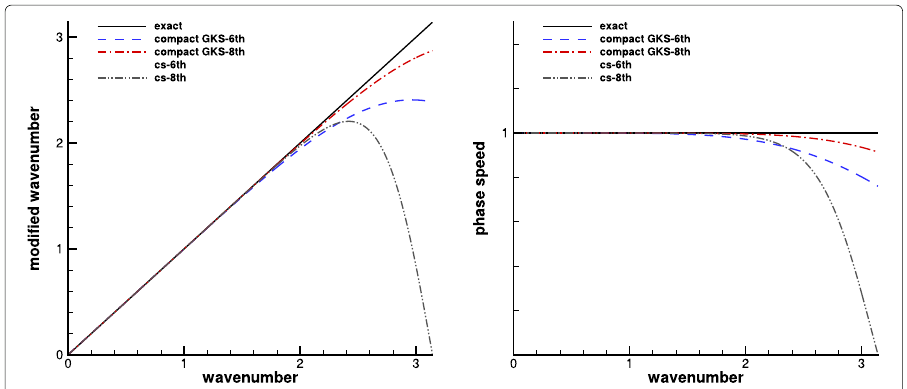
Fig. 2 Plots of modified wavenumber and phase speed vs wavenumber for different schemes. cs-6th is